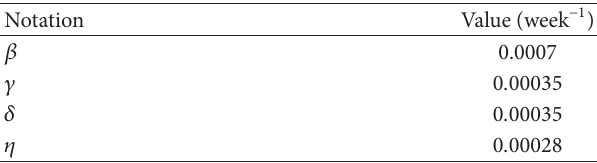
Table 1: Parameters used for numerical simulation [9].